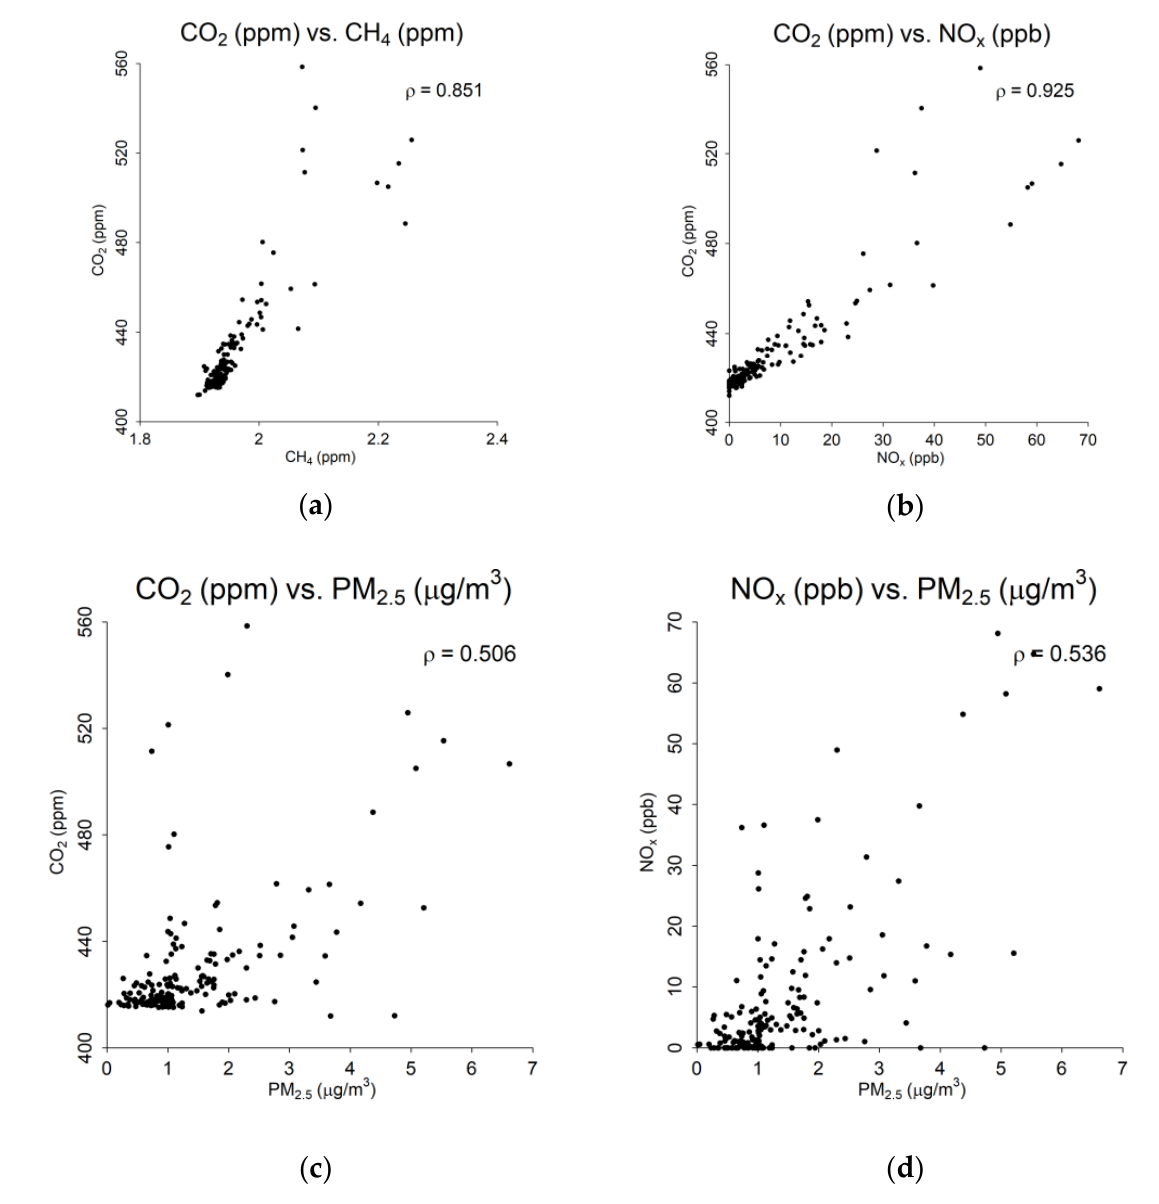
Figure 4. Van pollutant readings comparisons for Willow Springs campaign (10–17 January 2020) for ( a ) carbon dioxide vs. methane, ( b ) carbon dioxide vs. nitrogen oxides, ( c ) carbon dioxide vs. fine particulate matter, and ( d ) nitrogen oxides vs. fine particulate matter.